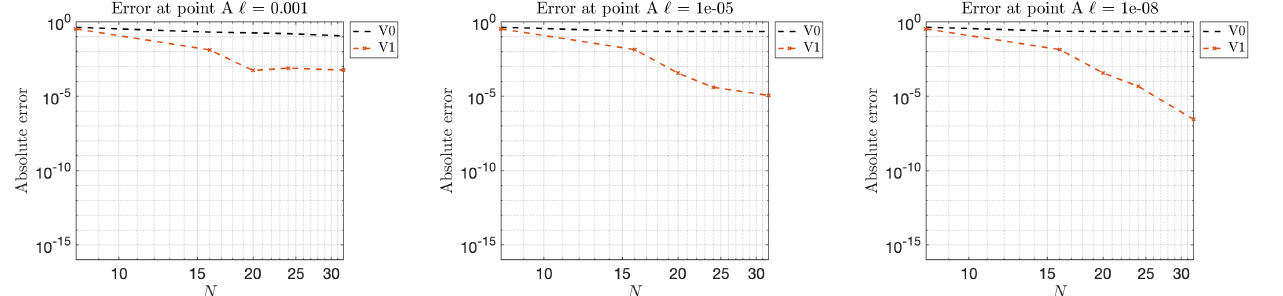
Figure 10. Helmholtz 3D. Log-plot of the maximum error for computing the solution as described in Figure 9 with ∂ D being the ellipsoid parameterized by y ( s , t ) = ( 2cos ( t ) sin ( s ) ,sin ( t ) sin ( s ) ,2cos ( s )) , ( s , t ) ∈ [ 0, π ] × [ − π , π ] , at some distance (cid:96) along the normal from point A= ( − 0.7664,0.0607,1.8433 ) .